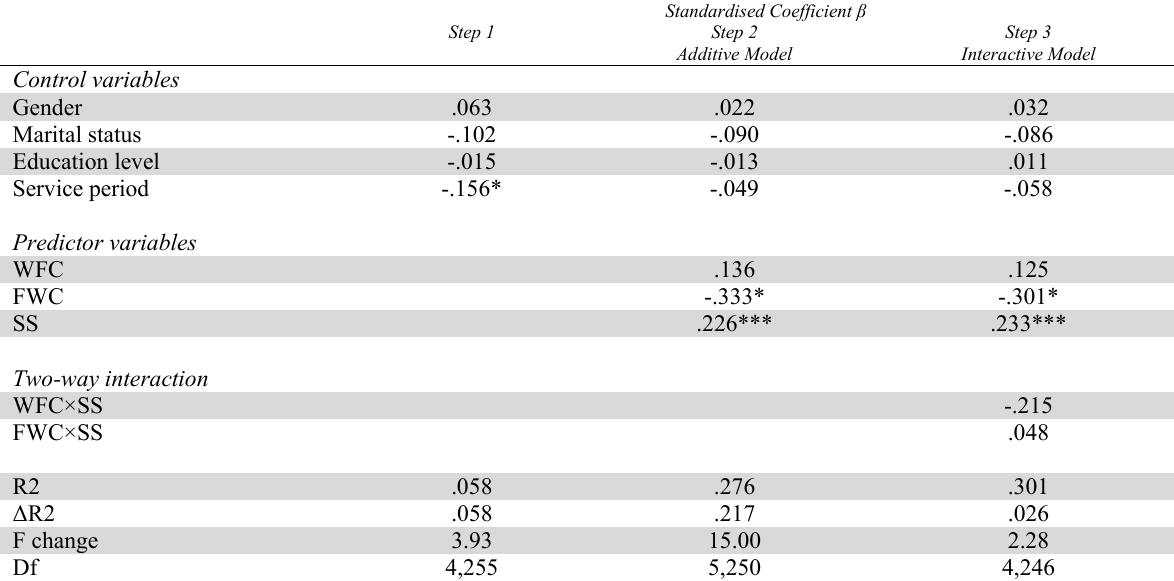
Results of hierarchical multiple regression